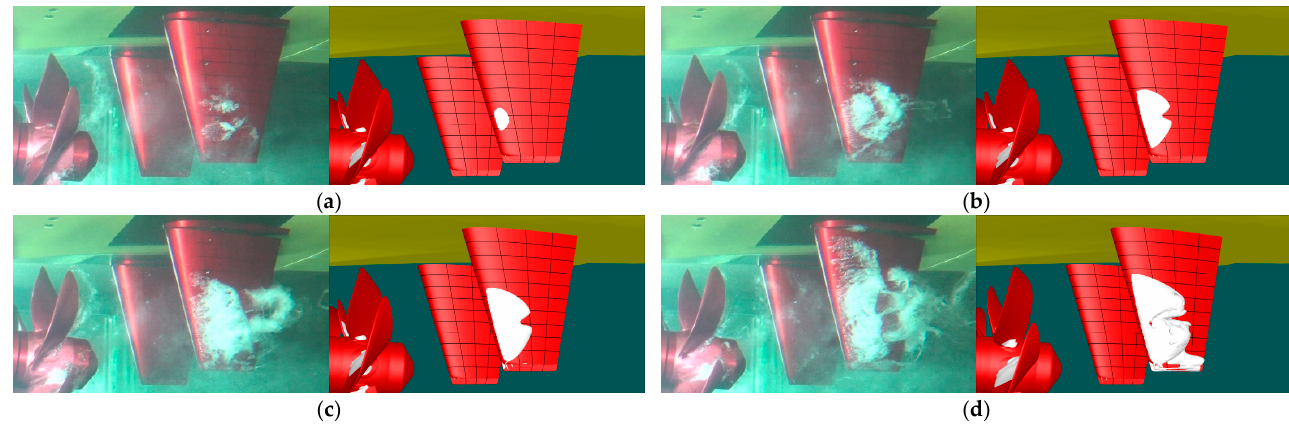
Figure 5. Experimental observation and numerical prediction of surface cavitation on the twin flat rudders: ( a ) δ R = 0 ◦ ; ( b ) δ R = − 4 ◦ ; ( c ) δ R = − 8 ◦ ; ( d ) δ R = − 12 ◦